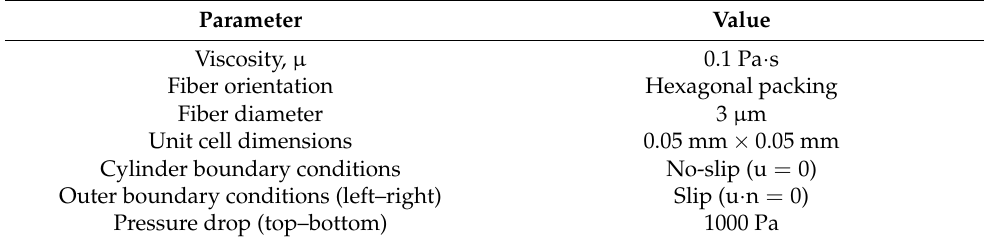
Figure 9. Model domain for numerical permability characterization: ( a ) CT image, ( b ) representative numerical model domain with the dry fiber bed with fibers (dark circles) and air (light areas). Table 6. Modeling parameters for the numerical permeability